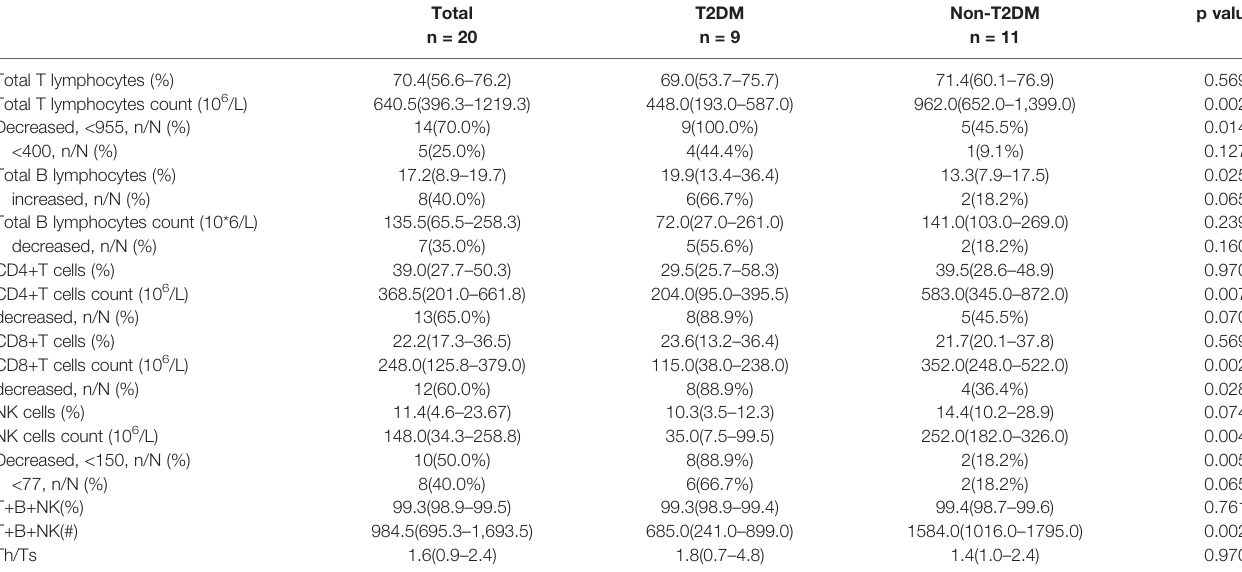
TABLE 2 | Comparing the counts and frequencies of immune cells on admission between T2DM and non-T2DM cases. Total